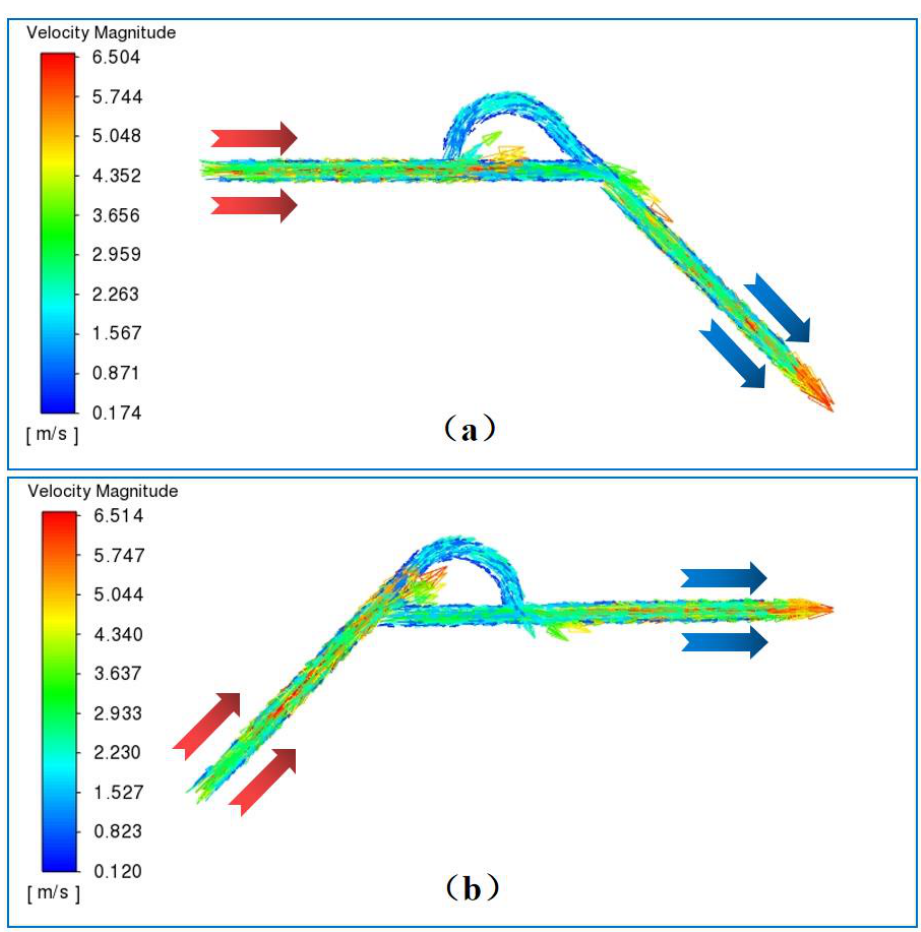
Figure 5. ( a ) Forward and ( b ) reverse flow of the Tesla valve (unit: m/s).